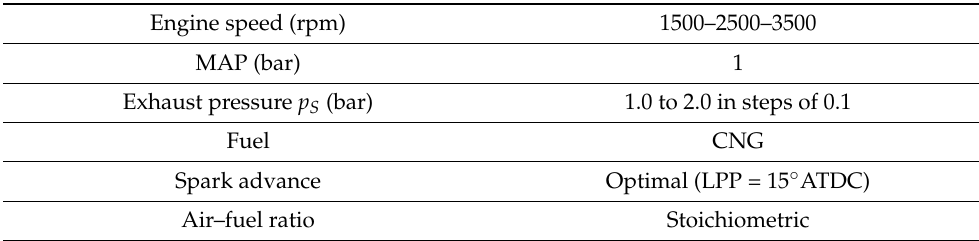
Table 5. Operating conditions of the experimental test.